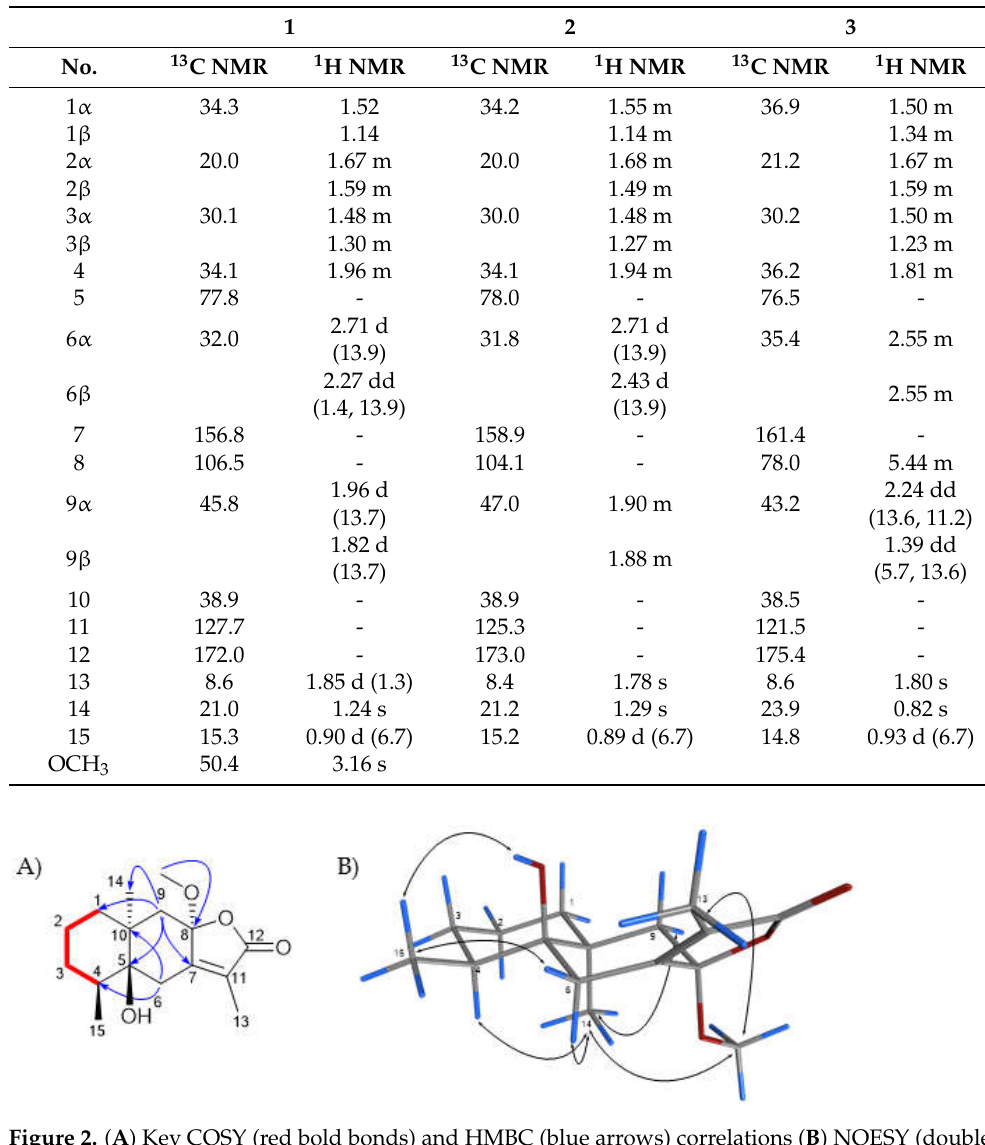
Table 1. NMR data for the three isolated ermiasolides from C. megalocarpus in CDCl 3 ( J in Hz).